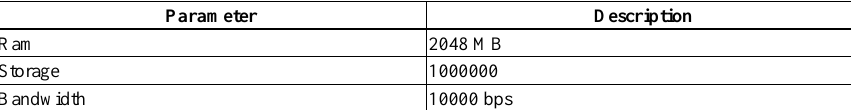
Table 4. DC (Data Center)